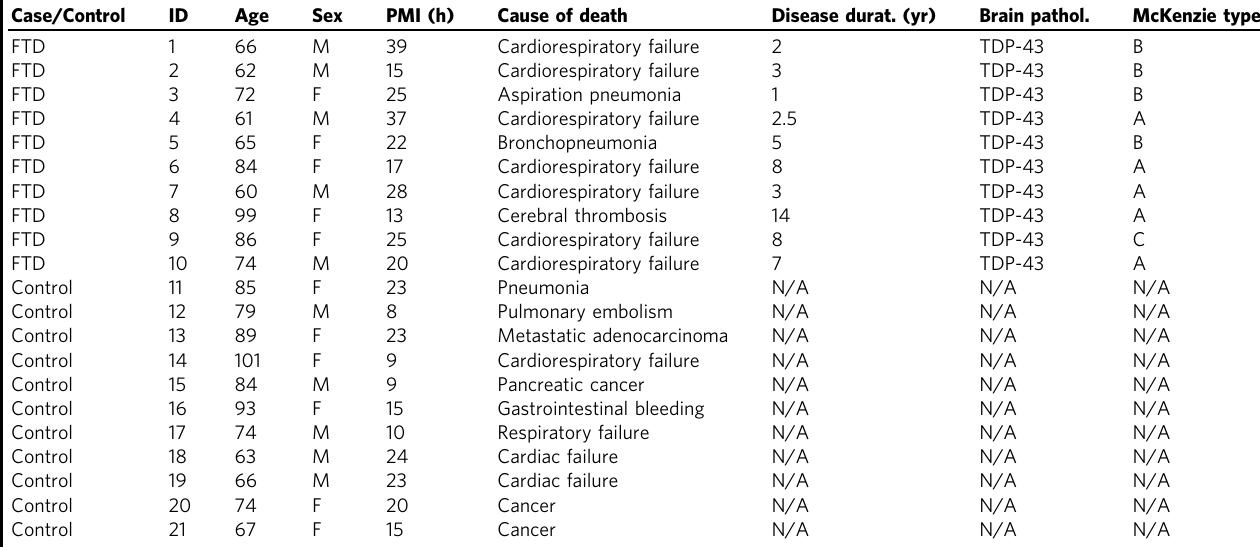
Table 1 FTD patient and control demographic and pathology information of brain tissue samples. Case/Control Disease durat. (yr) Brain